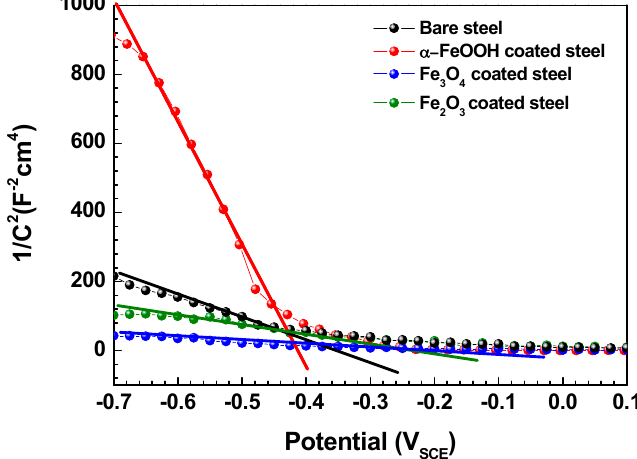
Figure 12. Mott-Schottky plots for iron oxides-covered and uncovered specimens immersed in the simulated district heating water for 340 h at 40 °C.